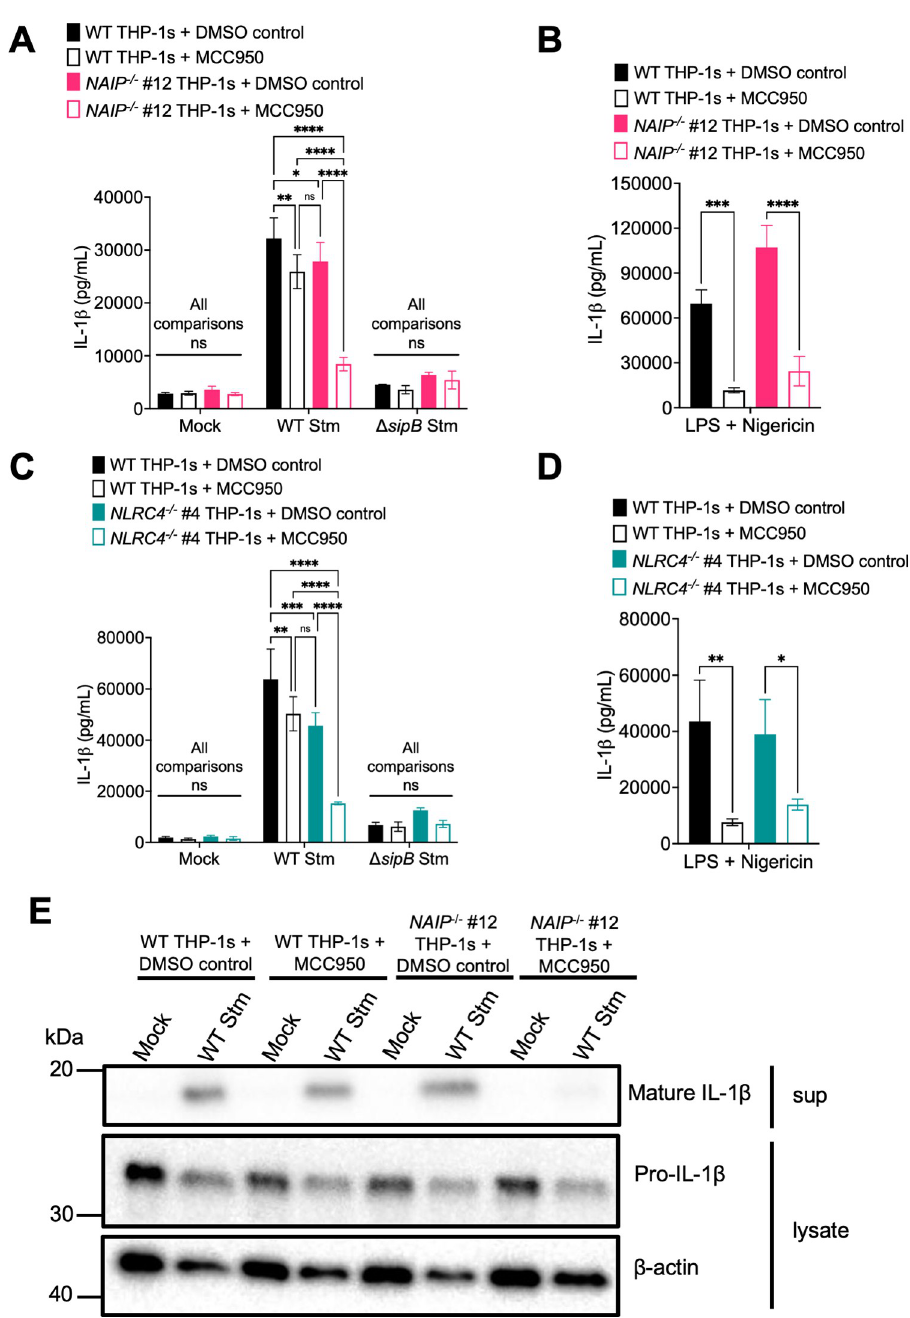
Fig 3. Salmonella induces NAIP/NLRC4- and NLRP3-dependent inflammasome activation in human macrophages. (A, C, E) WT, NAIP -/- , or NLRC4 -/- THP-1 monocyte-derived macrophages were primed with 100 ng/ mL Pam3CSK4 for 16 hours. One hour prior to infection, cells were treated with 1 μ M MCC950, a chemical inhibitor of the NLRP3 inflammasome, or DMSO as a control. Cells were then infected with PBS (Mock), WT S . Typhimurium, or Δ sipB S . Typhimurium at an MOI = 20 for 6 hours. (B, D) As a control, cells were primed with 500 ng/mL LPS for 4 hours and treated with 10 μ M nigericin for 6 hours. (A–D) Release of IL-1 β into the supernatant was measured by ELISA. (E) Immunoblot analysis was performed on supernatants (sup) for mature IL-1 β and on lysates for pro–IL-1 β and β -actin as a loading control. ns–not significant, � p < 0.05, �� p < 0.01, ��� p < 0.001, ���� p < 0.0001 by Tukey’s multiple comparisons test (A, C) or by Sˇı´da´k’s multiple comparisons test (B, D). Error bars represent the standard deviation of triplicate wells from one experiment. Data shown are representative of at least three independent